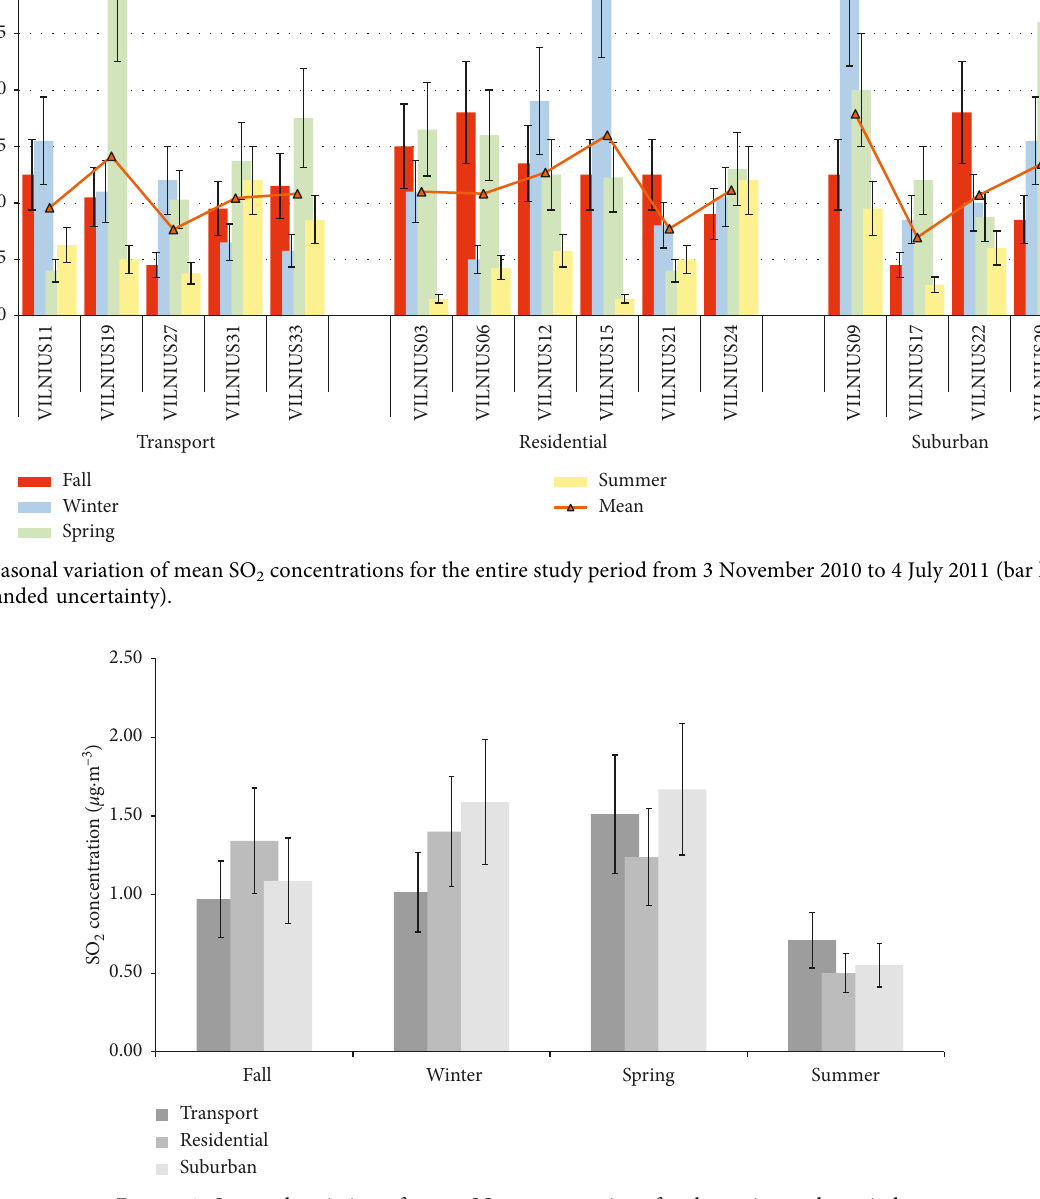
Figure 3: Seasonal variation of mean SO 2 concentrations for the entire study